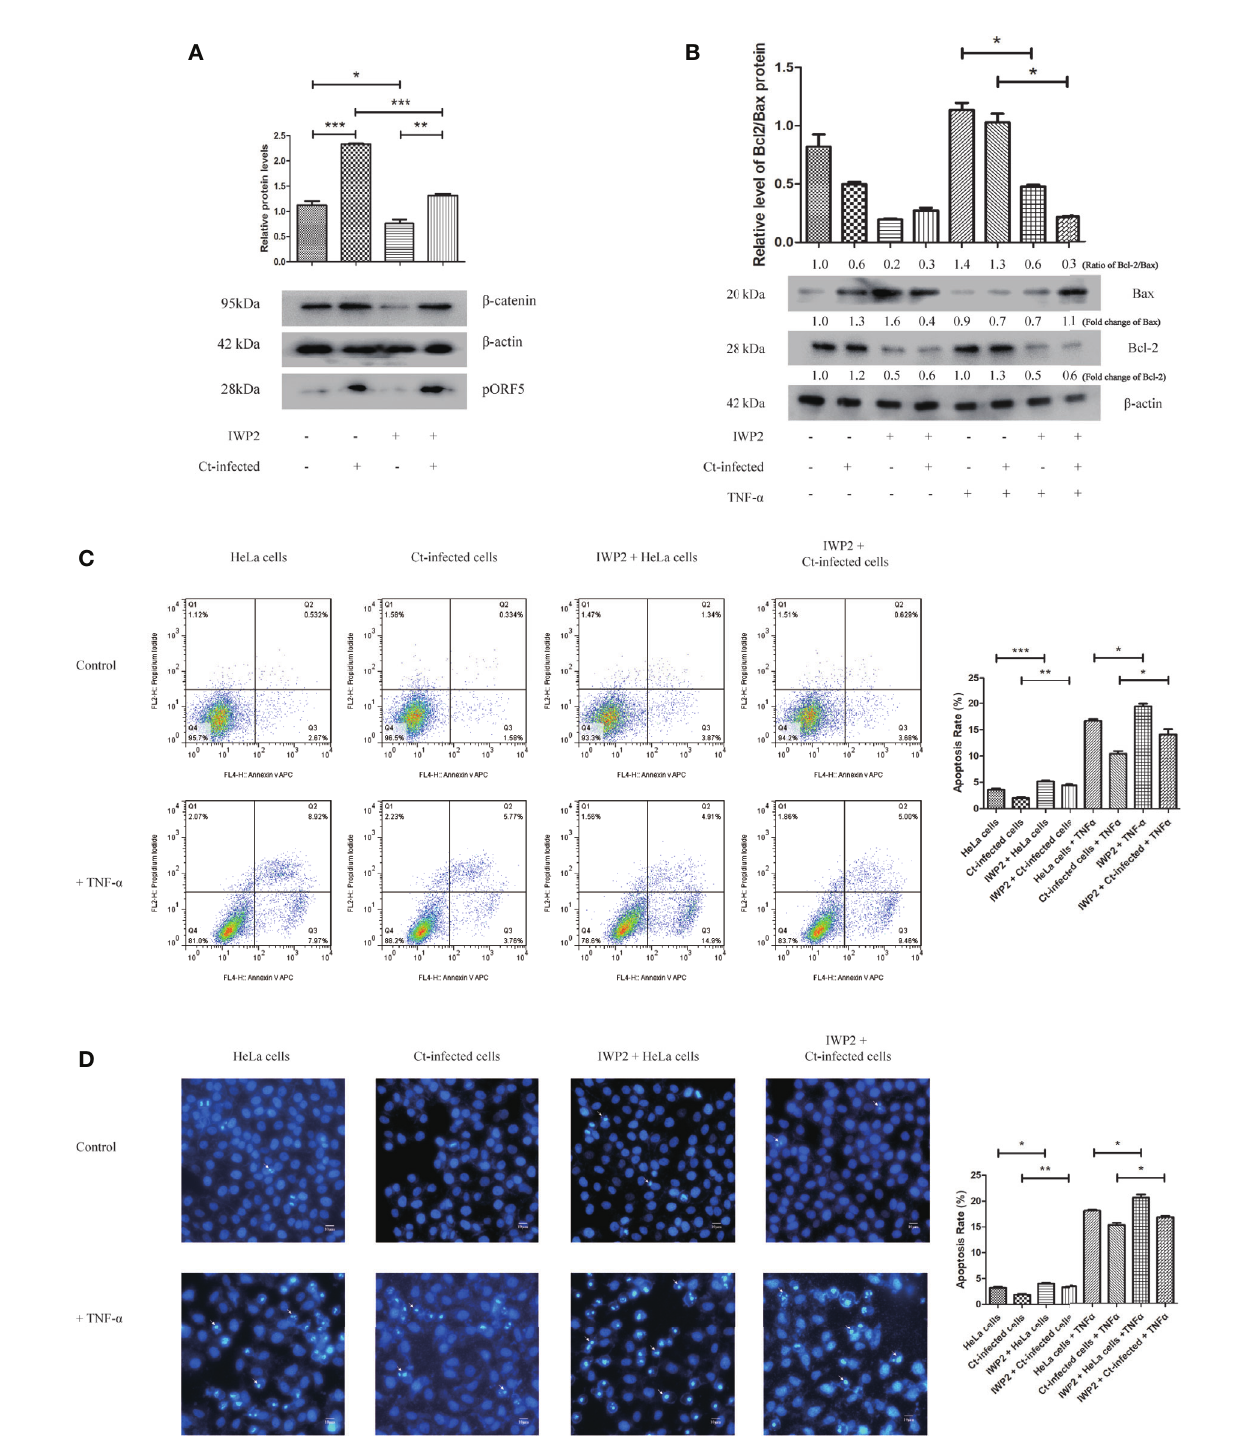
FIGURE 7 | Inhibition of Wnt signaling pathway suppresses the anti-apoptotic effect of Ct-infected cells. (A) The protein expression level of b -catenin was measured by western blot in HeLa cells and Ct-infected cells after the addition of Wnt signaling pathway inhibitor IWP2 (10 m M). The upper panel is the corresponding gray value of b -catenin calculated by Quantity One. (B) The expression of Bcl2 and Bax was measured by western blot in HeLa cells and Ct-infected cells after the inhibition of Wnt signaling pathway. The upper panel is the ratio of Bcl2/Bax and calculated by the corresponding gray value via Quantity One. (C, D) The apoptotic rate of Ct-infected cells and uninfected cells was detected by FCM (C) and Hoechst staining (D) after addition of IWP2 (10 m M). The left panel is the apoptosis rate calculated by corresponding experiment. Arrows in (C) denote apoptotic bodies. * P < 0.05; ** P < 0.01; *** P <